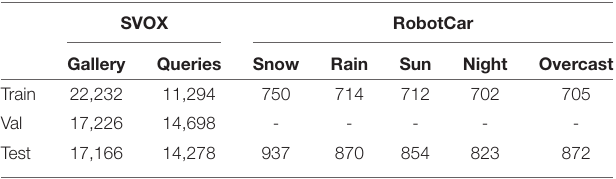
TABLE 1 | Sizes of SVOX dataset and Oxford RobotCar (Maddern et al., 2017) from 5 different